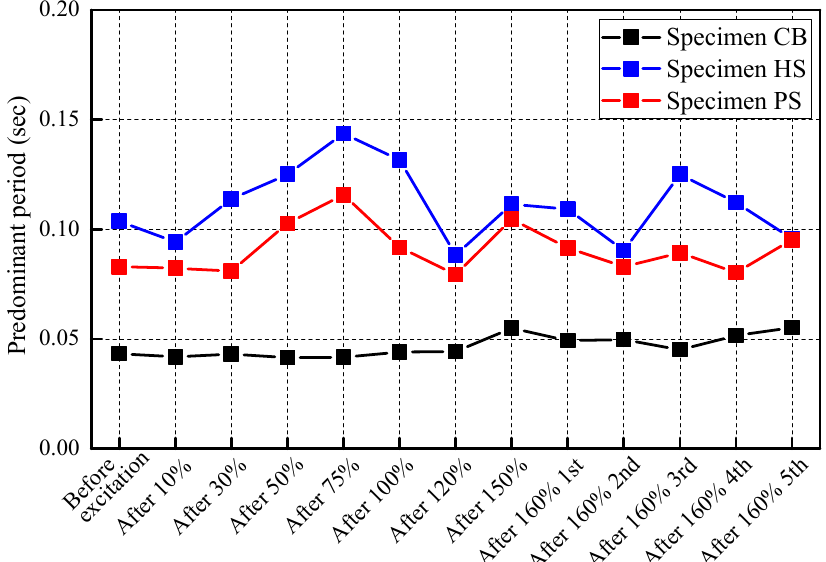
Figure 15. Development of predominant period of each specimen.